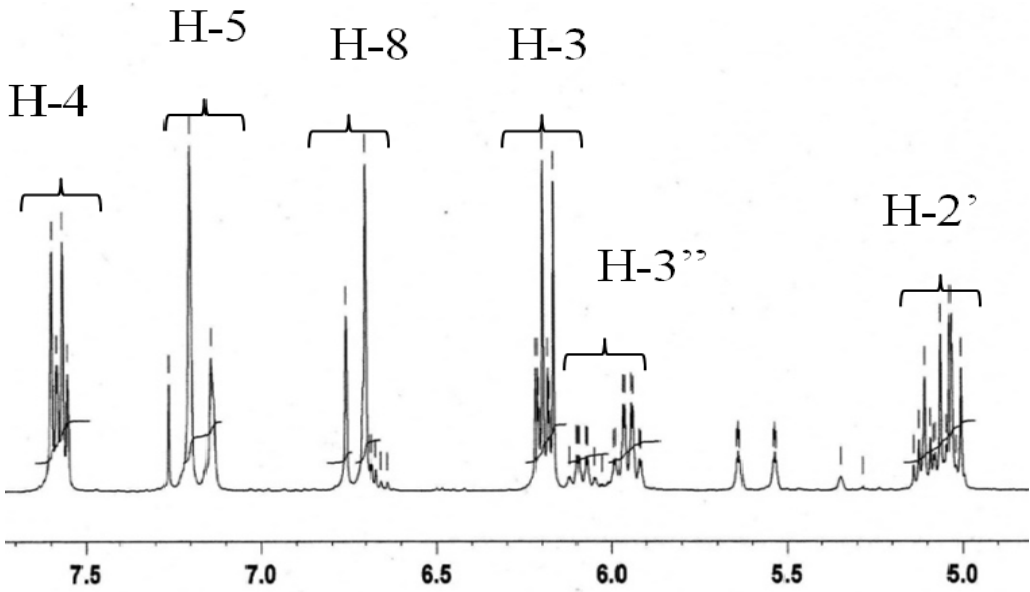
Figure 2. Duplication of signals in 1 H-NMR of the mixture of compounds 1a and 1b